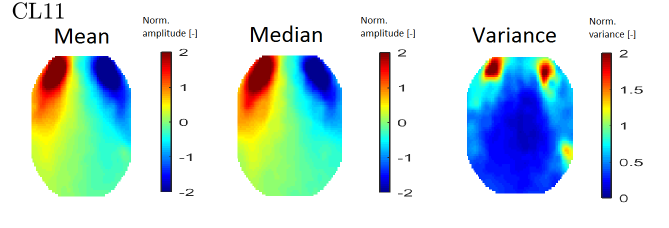
Figure 6. An example of all map types—mean topomaps from cluster 11 ( left ), median topomaps from cluster 11 ( middle ) and variance topomaps from cluster 11 ( right